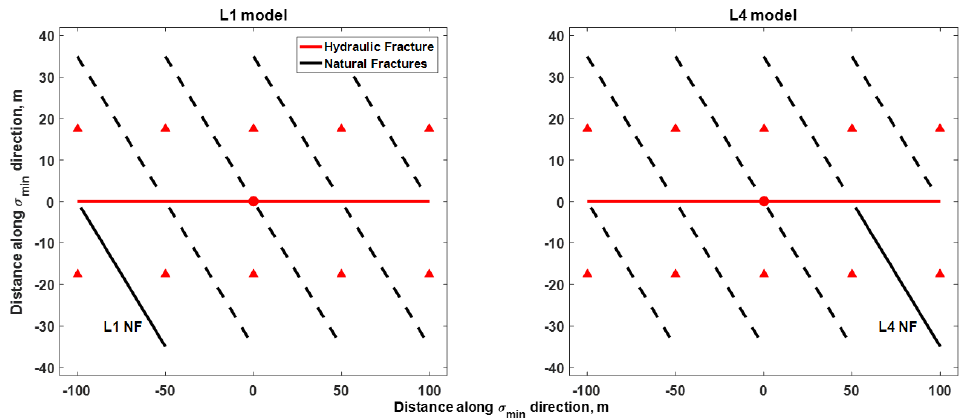
Figure 9—Model setup with only one NF.